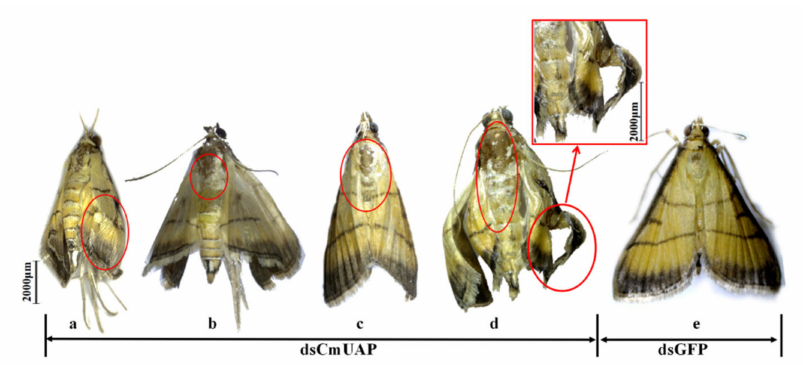
Figure 11. Abnormal morphology of C. medinalis adults after dsRNA injection. ( a ), abnormal wing folding; ( b ), abnormal wing unfolding; ( c ), wings failing to cover the abdomen; ( d ), wing curling; ( e ), ds GFP -injected adult. Malformed phenotypes are marked with red circles. Scale bar represents 2000 µ